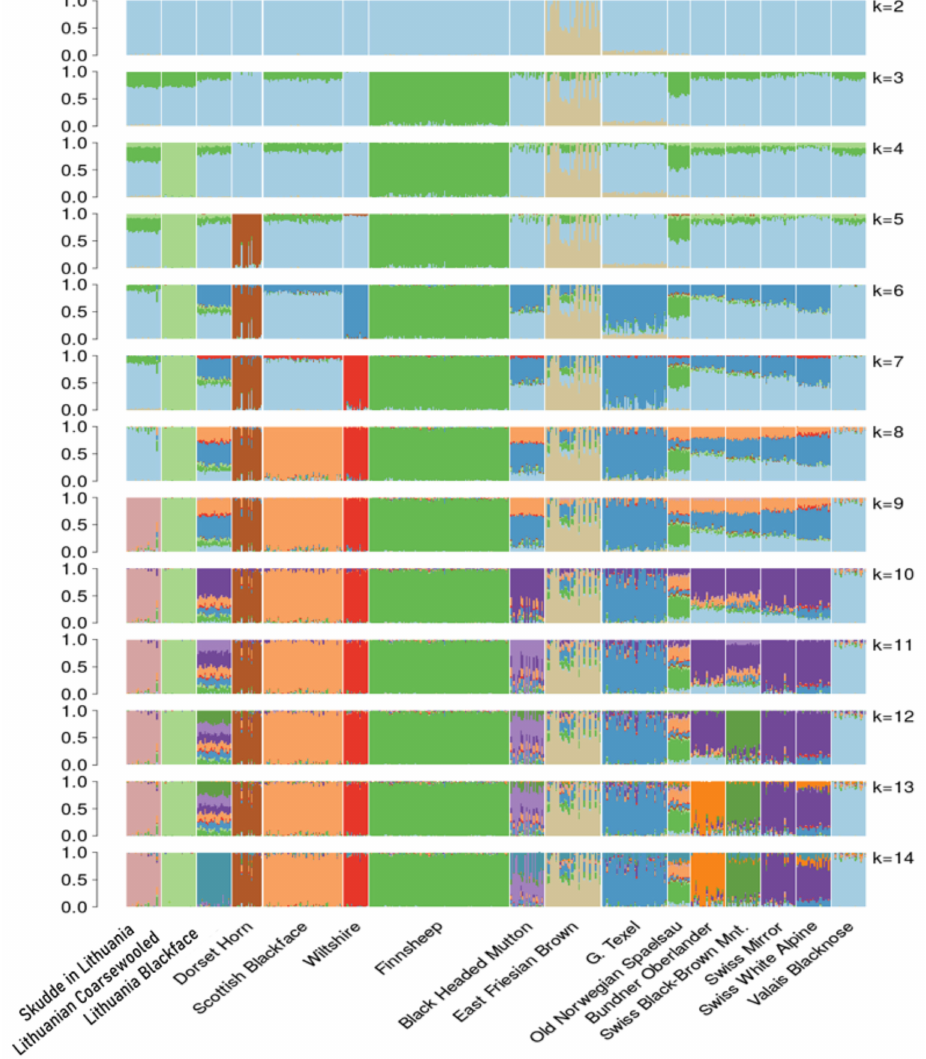
Figure 3. Bar charts describing the model-based clustering results for the models varying the assumed population number, k, from 2 to 14. Each thin bar represents an animal, and the bar is divided to different colours representing the estimated ancestry proportion for the individual animal. Sheep from the same population are grouped together and separated from the neighbouring breed by a